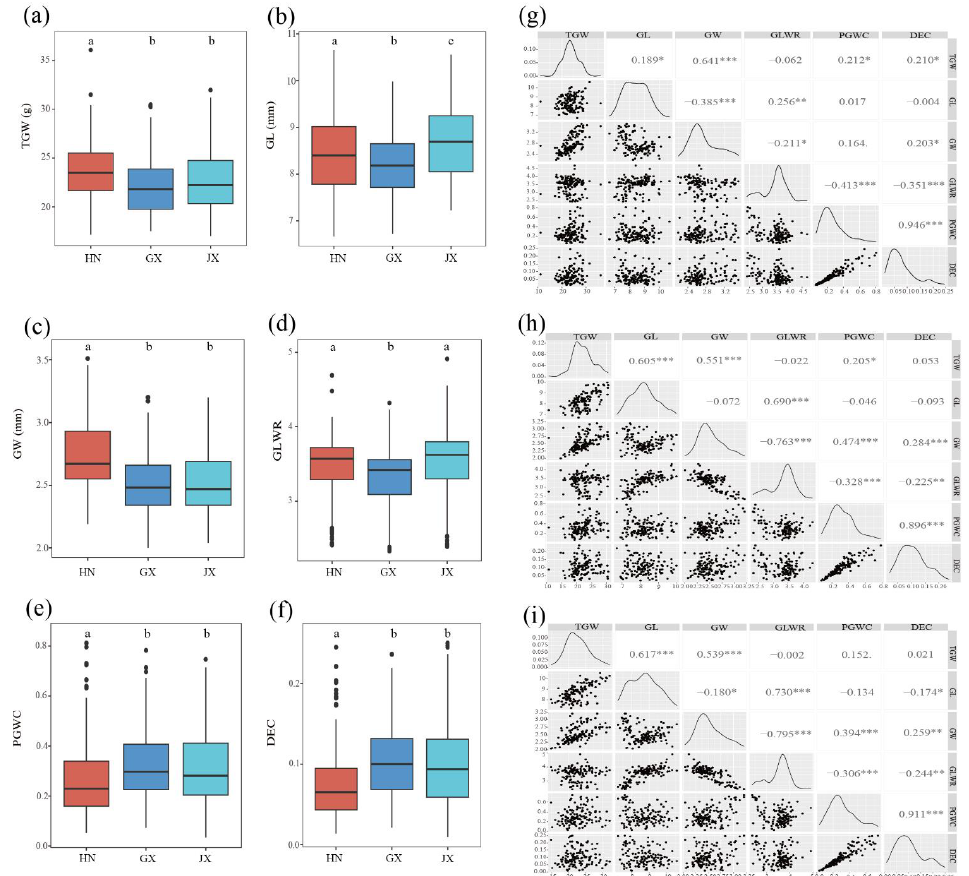
Figure 1. Box plots of six rice grain appearance and milling quality traits in three environments and phenotypic correlations of six traits in different environments. HN, Hainan; GX, Guangxi; JX, Jiangxi; ( a ) thousand grain weight; ( b ) grain length; ( c ) grain width; ( d ) grain length to width ratio; ( e ) percentage of grains with chalkiness; ( f ) degree of endosperm with chalkiness; ( g ) Hainan; ( h ) Guangxi; ( i ) Jiangxi; ‘*’, ‘**’, and ‘***’ refer to significant correlations ( p < 0.05, p < 0.01, and p <